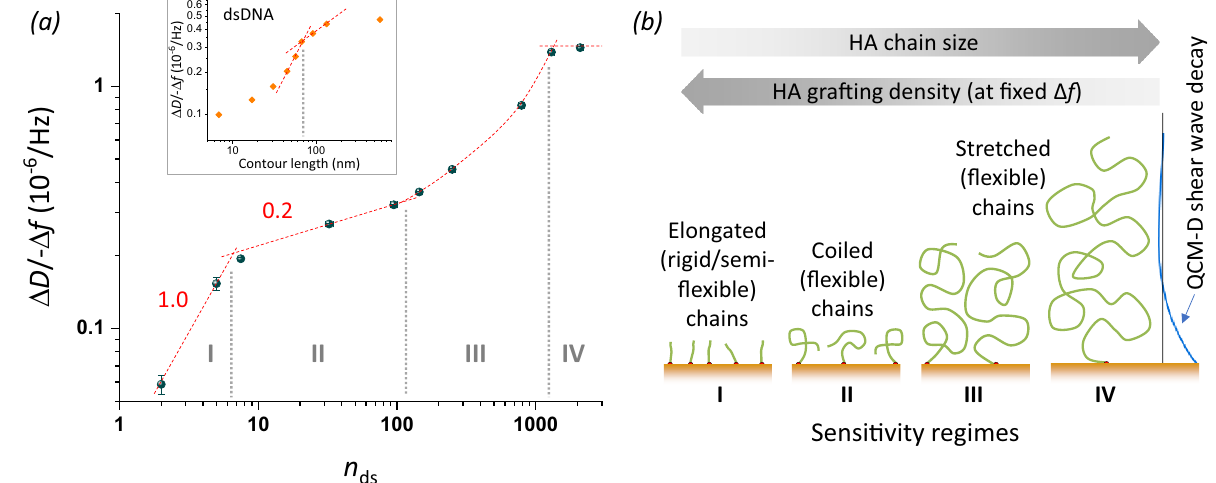
Figure 8. Sensitivity regimes of HA and underpinning mechanisms. ( a ) Double-logarithmic plot of the Δ D /− Δ f ratio ( i = 3) at low HA surface density (− Δ f = 2.5 Hz) as a function of the mean number of disaccharides, n ds . Data for HA (blue spheres with error bars) are reproduced from Fig. 4. Sensitivity regimes I–IV are separated by vertical grey dotted lines. Regimes I and II are discerned by their distinct power-law dependencies (red dashed lines with slope illustrate the approximate power); regime III does not obey a power law (red curved dashed line illustrates the trend) and regime IV is close to a plateau/maximum (indicated by a horizontal line). The inset shows equivalent data for dsDNA extracted from Fig. 3 of Ref. 46 , with two selected power law dependencies (dashed red lines). ( b ) Illustration of the proposed model to explain the observed sensitivity regimes. Both HA chain size and grafting density (which decreases with increasing chain size at the set − Δ f = 2.5 Hz) influence chain conformation, and distinct chain conformations are associated with sensitivity regimes I, II and III; ultimately, chain stretching exceeds the QCM-D sensing depth leading to a Δ D /− Δ f maximum and vanishing size sensitivity in regime